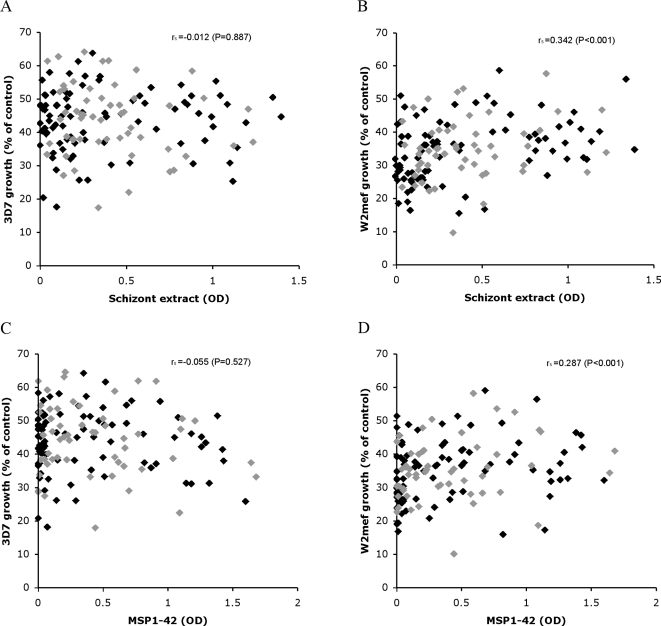
The association between in vitro growth of parasite lines 3D7 or W2mef and IgG measured by ELISA, according to parasitemic status, for the Ngerenya 1998 cohort.A, B: Correlation between ELISA response to schizont extract and 3D7 or W2mef growth, respectively. C, D: Correlation between ELISA response to MSP1-42 and 3D7 or W2mef growth, respectively. rs values represent Spearman's rank correlation coefficients. Results for aparasitemic and parasitemic individuals are represented by black or grey diamonds, respectively. Samples used in growth-inhibition assays were dialysed serum.